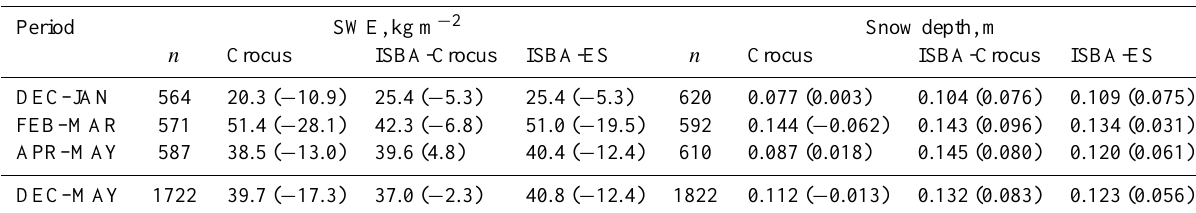
Table 5. Statistics for the snow seasons 2001 to 2011 at Col de Porte for four time periods (DEC–JAN, FEB–MAR, APR–MAY and DEC– MAY) using Crocus, ISBA-Crocus and ISBA-ES. Results are given in terms of rmsd (bias) for SWE and snow depth, respectively. The number of (measurement,simulation) pairs considered for the statistics n is provided for each time period and variable. SWE and snow depth values are provided in kgm − 2 and m,